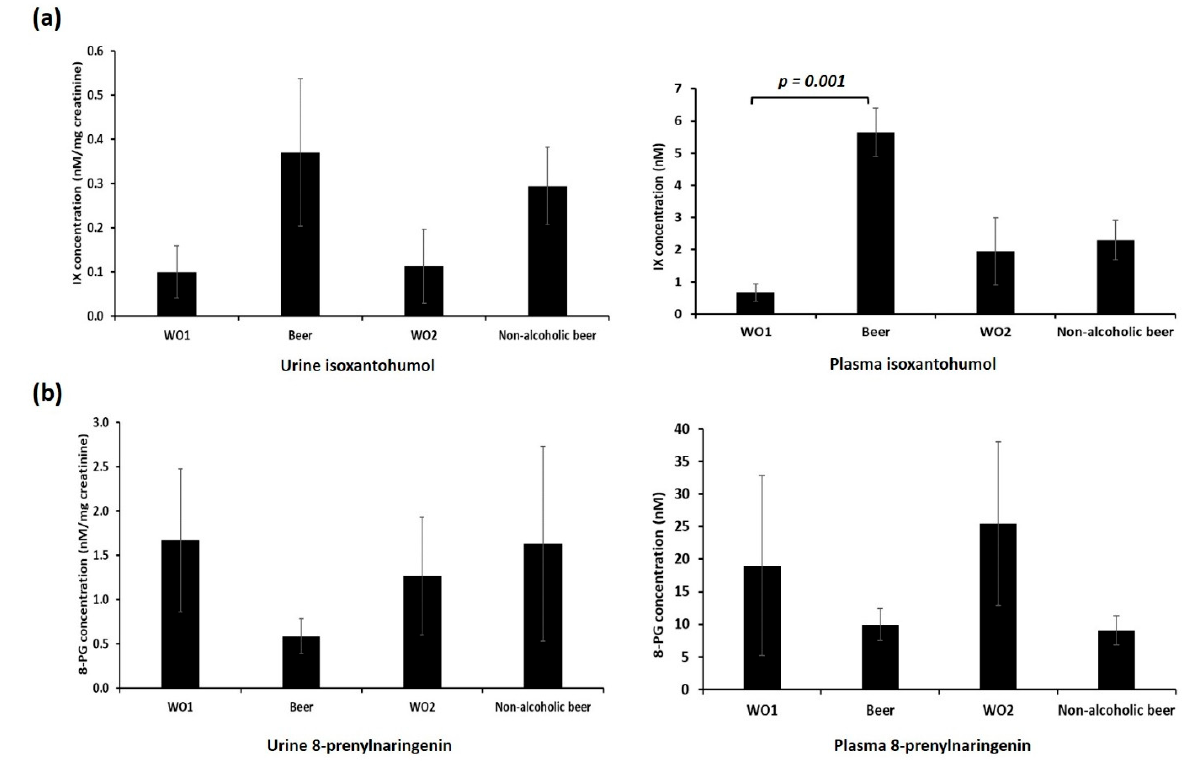
Figure 1. Plasma and urine ( a ) isoxanthohumol (IX) and ( b ) 8-prenylnaringenin (8-PG) levels. Plasma and urine IX and 8-PG levels were measured by mass spectrometry. p -value refers to the intra-subject comparison of the paired Student’s t -test. WO1: washout 1, Beer: alcoholic beer intervention; WO2: washout 2, non-alcoholic beer: non-alcoholic beer intervention. Data represent mean ± SD.